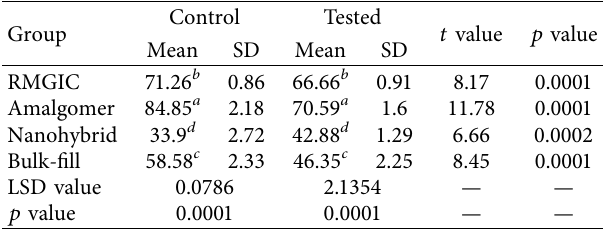
Table 1: Student’s t -test, ANOVA, and post hoc tests of the surface microhardness